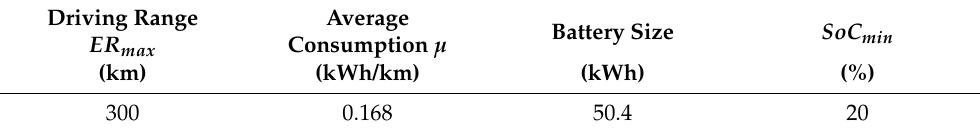
Table 5. Characteristics of a representative EV of the B segment of the market. Driving Range ER